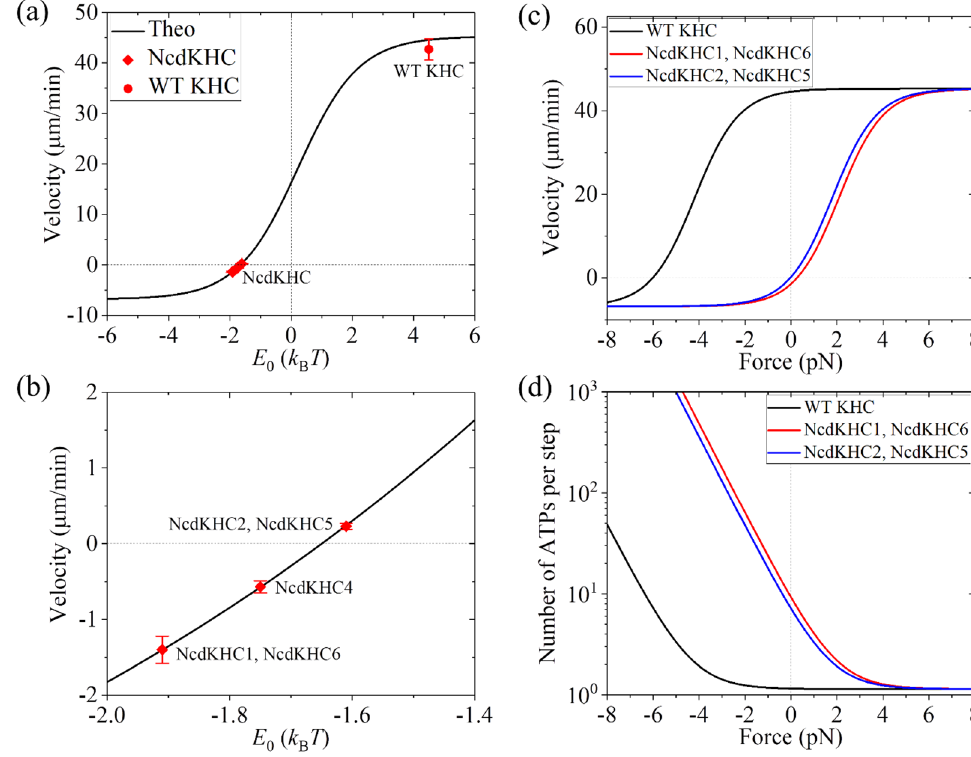
Figure 7. Dynamics of NcdKHC motors. WT and NcdHKCs represent the wild-type K560 and the engineered motor consisting of the Ncd stalk and neck joined to the KHC motor domain, respectively. Lines are theoretical results. Symbols are experimental data taken from Endow and Waligora [40]. ( a ) Velocity versus E 0 under no load. ( b ) Enlargement of ( a ) in the range of E 0 from − 2 k B T to − 1.4 k B T . ( c ) Velocity versus backward and forward loads for the WT and NcdHKCs. ( d ) Number of ATPs consumer per step versus backward and forward loads for the WT and NcdHKCs.